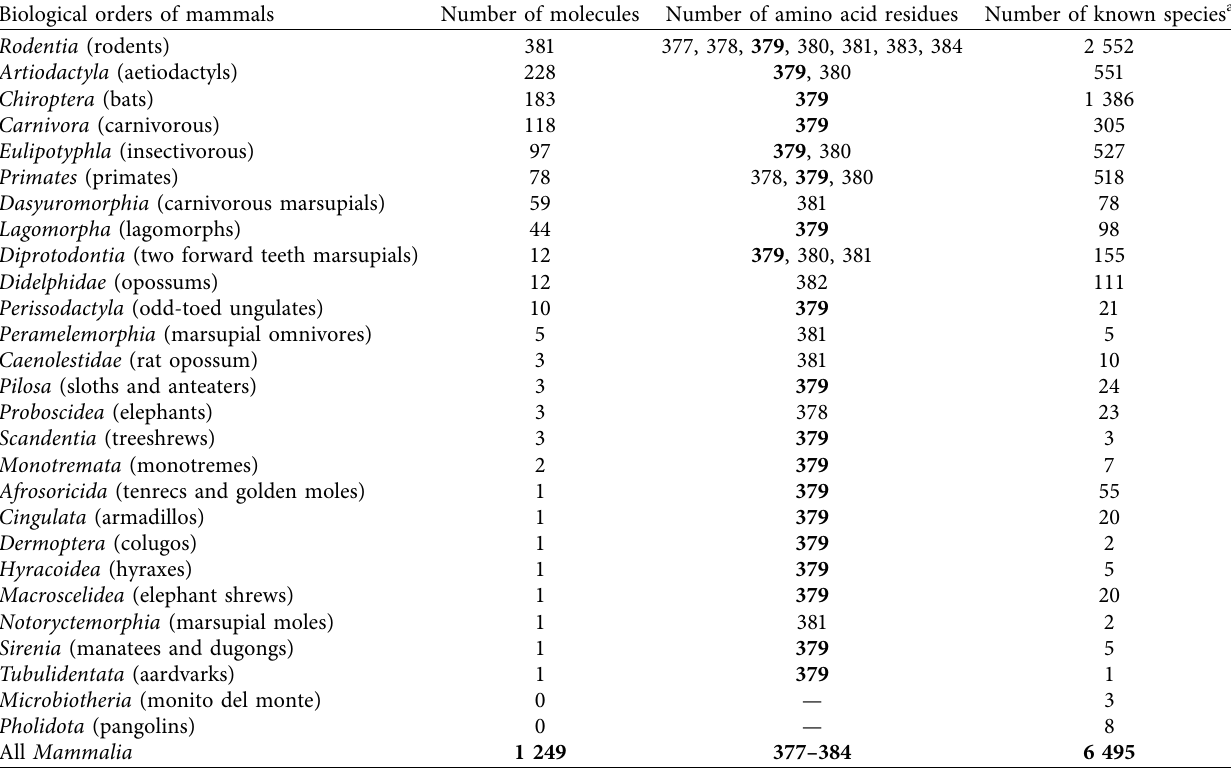
Table 5: Content of the number of cytochrome b amino acid sequences in the Swiss-Prot database in various biological orders of mammal ( Mammalia )